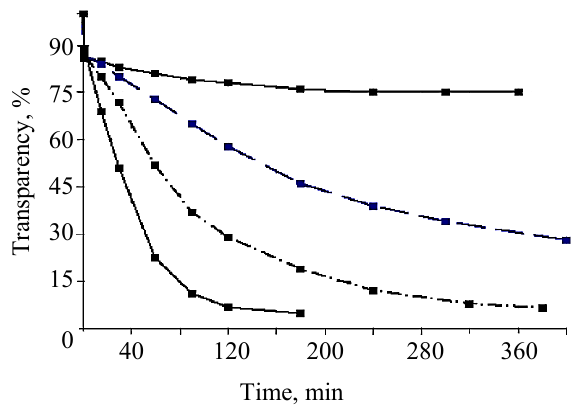
Fig. 4. Change in the transparency of solutions during crystallization depending on the excess concentration of the solution (Δ C ), g/100 g of water: ___ 15 ; __ __ 44; __ . __ . __ 59; – - – 88.